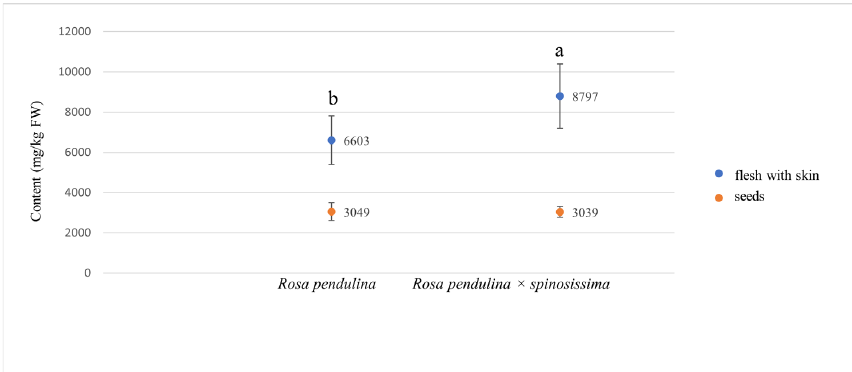
Figure 2. Comparison of total analyzed phenolic contents (mg/kg FW) in flesh with skin and seeds of R. pendulina hips and the hybrid genotype R. pendulina × spinosissima in the region of Western Slovenia in 2020. Mean values with corresponding standard deviations are presented. Different letters signify statistical differences between the two genotypes. The comparison between genotypes was made separately for seeds and for flesh with skin. The total hydroxybenzoic acid (HBA) derivative content was significantly higher in R. pendulina (flesh with skin 1151.0 mg/kg FW and seed 980.7 mg/kg FW) than in R. pen- dulina × spinosissima (flesh with skin 2336.5 mg/kg FW and seed 189.7 mg/kg FW). This was true for both flesh and seeds. From the group of hydroxycinnamic acids, five p-cou- maric acid derivatives, two synapic acid derivatives, and two caffeic acid derivatives were found. The hybrid R. pendulina × spinosissima was characterized by an extremely high con- tent of total hydroxycinnamic acids. This was true for both the pulp (990.6 mg/kg FW) and the seeds (222.5 mg/kg FW). Table 2. The contents ± standard deviations (mg/kg FW) of phenolic compounds in hips of R. pendulina and the hybrid R. pendulina × spinosissima in the region of Western Slovenia in 2020. Different letters indicate statistical differences between the two genotypes, separately for flesh with skin and